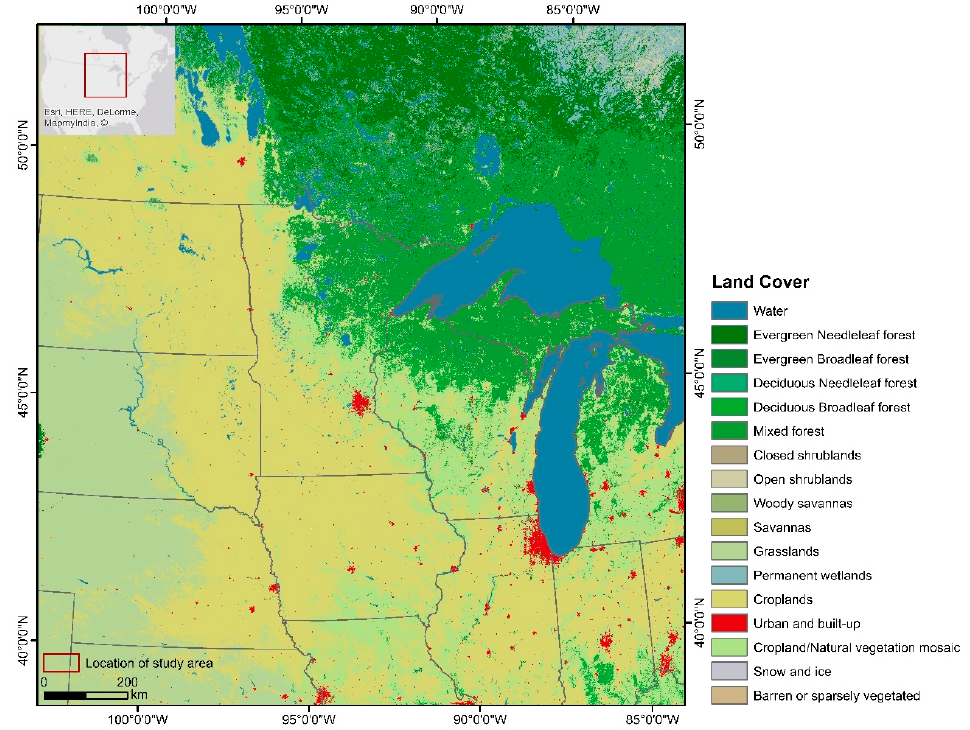
Figure 1. Study area with land cover types representing the portion of Central and Western Canada and the Midwestern United States.